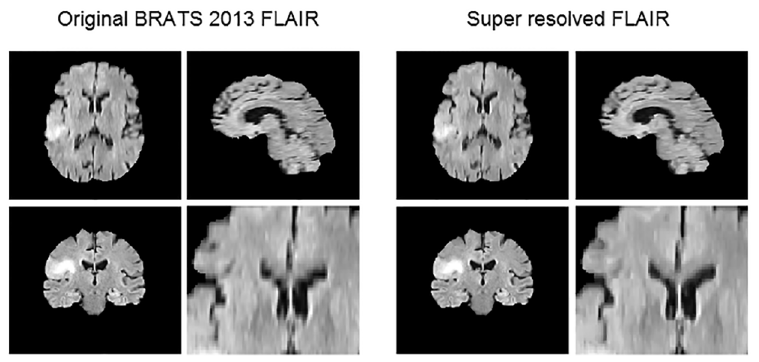
Fig 2. Example of super resolution using Non-local Upsampling of a Flair sequence of the BRATS 2013